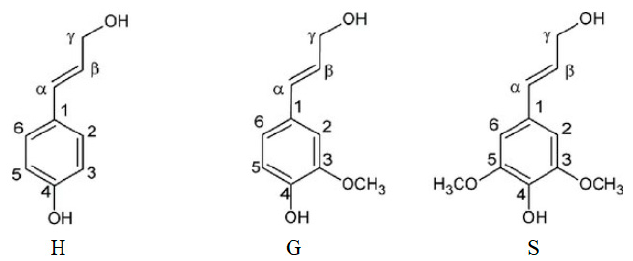
Figure 4. Lignin building blocks: p -coumaryl alcohol (H), coniferyl alcohol (G), and sinapyl alcohol (S).